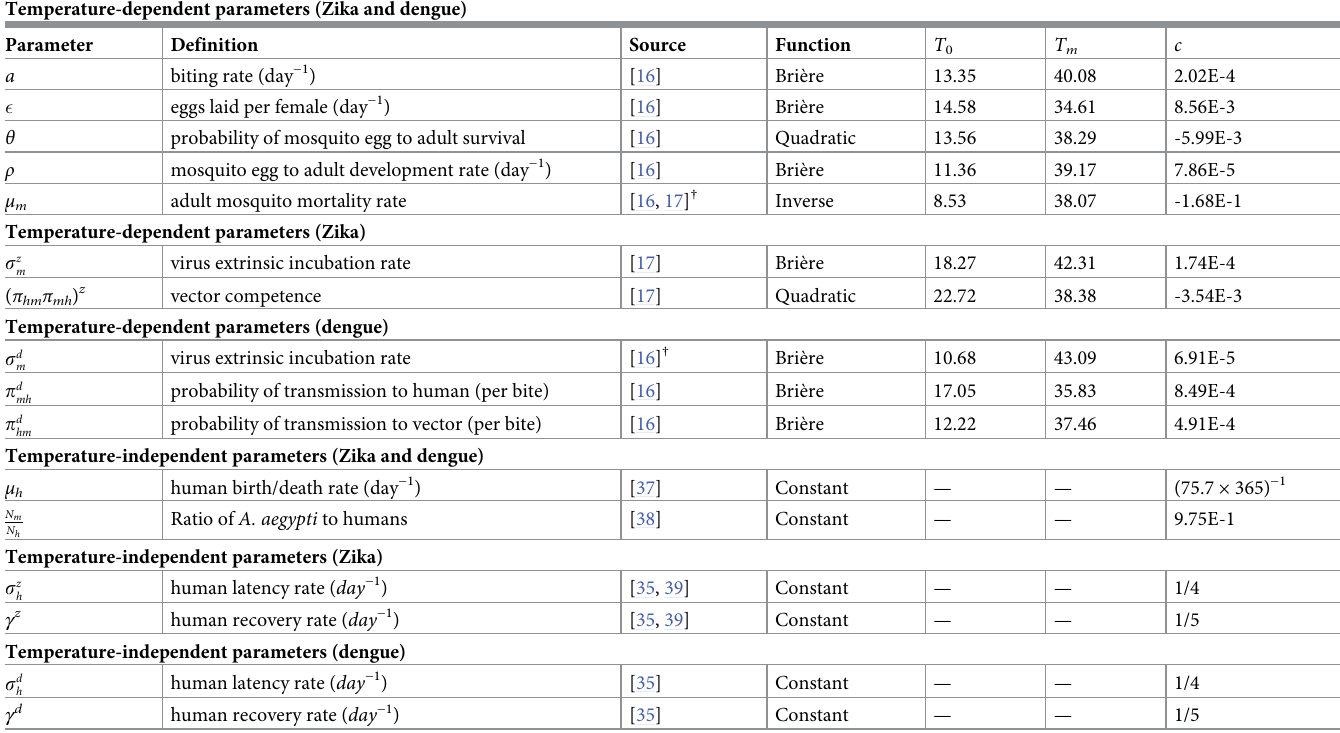
Table 1. Parameters of the temperature-dependent vector-borne arbovirus disease transmission model. Adult mosquito mortality rate and extrinsic incubation period were refit by the authors (indicated by † and given in Section 4, Fig D and E in S1 Appendix), while the remaining traits were taken directly from the source listed. Temperature-dependent parameters (Zika and